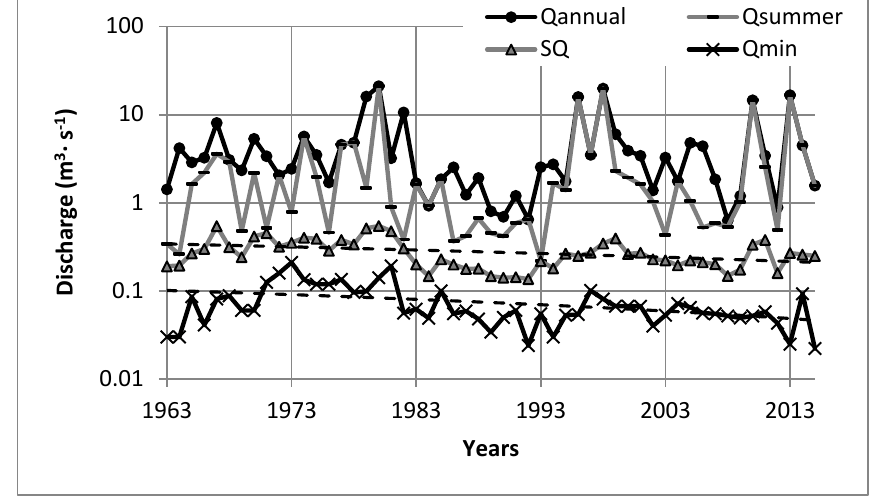
Figure 6. Maximum annual (Qannual), maximum summer (Qsummer), mean annual (SQ) and minimum annual (Qmin) discharge for the Zagożdżonka watershed upstream of the Płachty gauge station in the period 1963–2015; significant decreasing trends in SQ and Qmin.